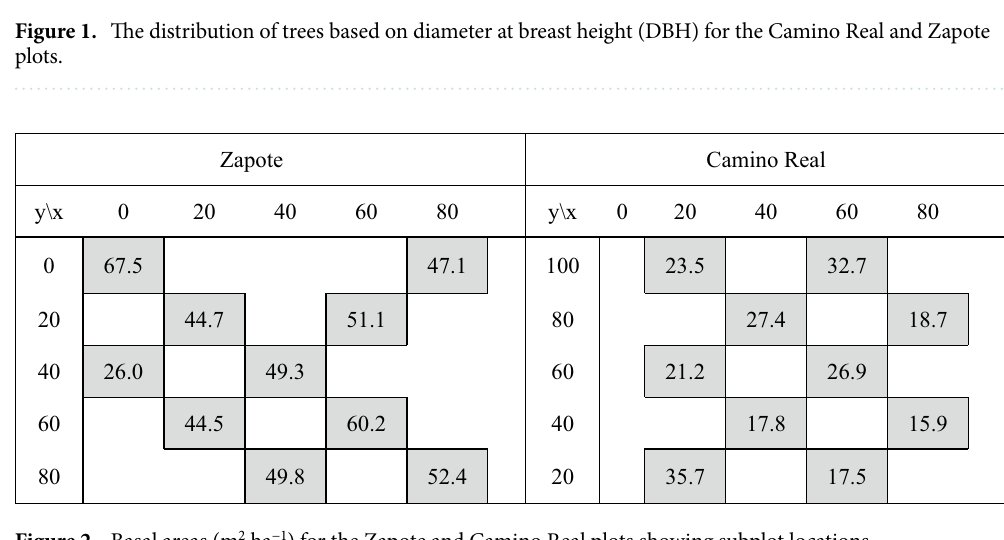
Figure 2. Basal areas (m 2 ha −1 ) for the Zapote and Camino Real plots showing subplot